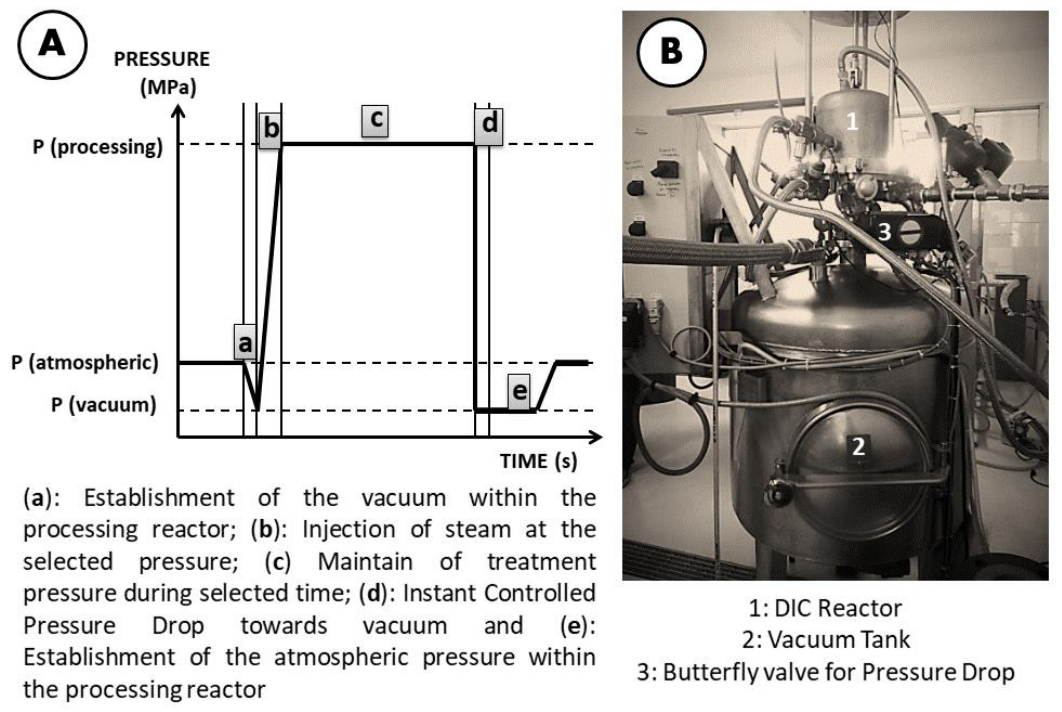
Figure 8. ( A ) Schematic time-pressure profiles of the instant controlled pressure drop (DIC) processing cycle and ( B ) DIC reactor LABIC0.1. (ABCAR DIC Process).